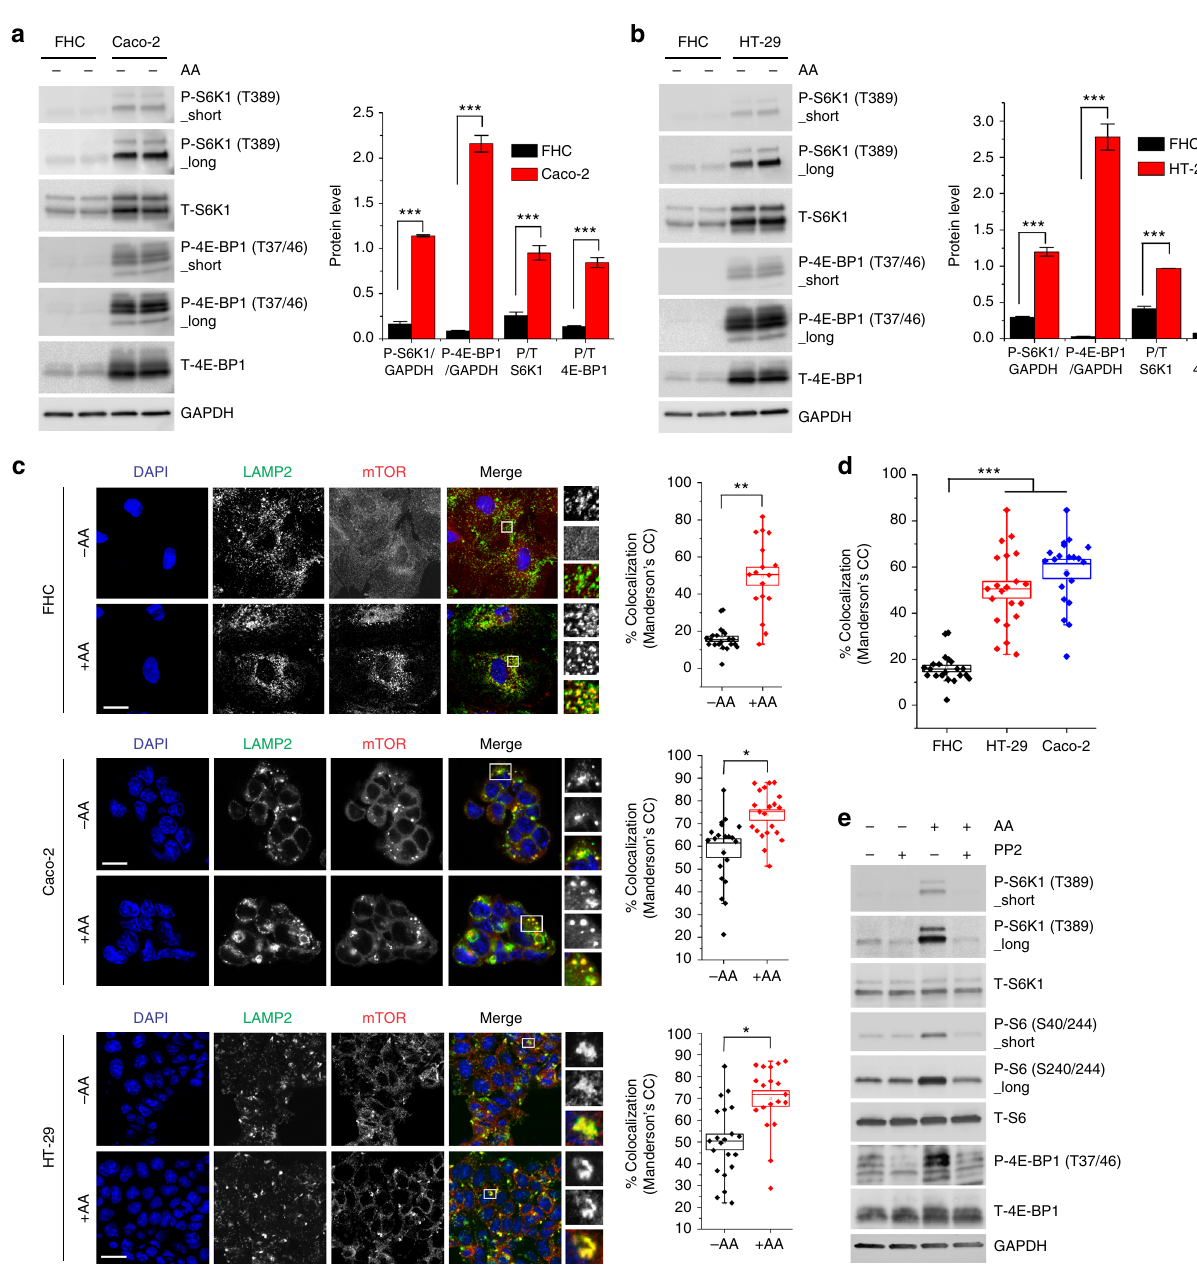
Fig. 5 Increased mTORC1 activity in cells with elevated Src activity. a FHC and Caco-2 cells were amino acid starved (kept in dialyzed serum) for 4 h prior to lysis and immunoblot analysis to measure the levels of the indicated proteins and phosphorylation states. b FHC and HT-29 cells were treated as in a prior to immunoblot analysis to measure the levels of the indicated proteins and phosphorylation states. Quanti fi ed data in a and b represent means ± SEM of n = 2 – 3 independent experiments. ** p < 0.001. c FHC, Caco-2 and HT-29 cells were starved as in a and then stimulated with amino acids for 30 min prior to immuno fl uorescence labeling of endogenous LAMP2 (green) and mTOR (red). Bars indicate 40 μ m in FHC cells and 80 μ m in Caco-2 and HT- 29 cells. Representative cells are shown where yellow or orange pixels indicate co-localization in the merged images. Insets show selected fi elds that were magni fi ed by a factor of 6. Quanti fi ed data represent co-localization (Mander ’ s coef fi cient) means of mTOR and LAMP2 in at least 15 cells for each condition. * p < 0.05 and ** p < 0.01. d Extent of co-localization of mTOR and LAMP2 in FHC, Caco-2 and HT-29 cells under amino acid starvation. Box plots in c and d represent quanti fi ed data of co-localization (Mander ’ s coef fi cient) analysis in at least n = 30 cells/line. *** p < 0.001. e Caco-2 cells were amino acid starved (kept in dialyzed serum) for 4 h and treated with PP2 for the last 2 h prior to 30-min amino acid stimulation. Cells were lysed and immunoblot analyses were performed to measure the levels of the indicated proteins and phosphorylation states. Statistical differences between groups in a – d were determined using ANOVA with Tukey ’ s post hoc Immunoprecipitation . For the immunoprecipitation analyses regulator compo- microscope with Apotome feature engaged or a Zeiss 710 confocal laser microscope nents, cells were rinsed once with ice-cold PBS and lysed with ice-cold Chaps lysis (Zeiss, Oberkochen, Germany). Representative images are shown in all fi gures at the same exposure and magni fi cation. Antibody details are provided in Supple- mentary Table 2.